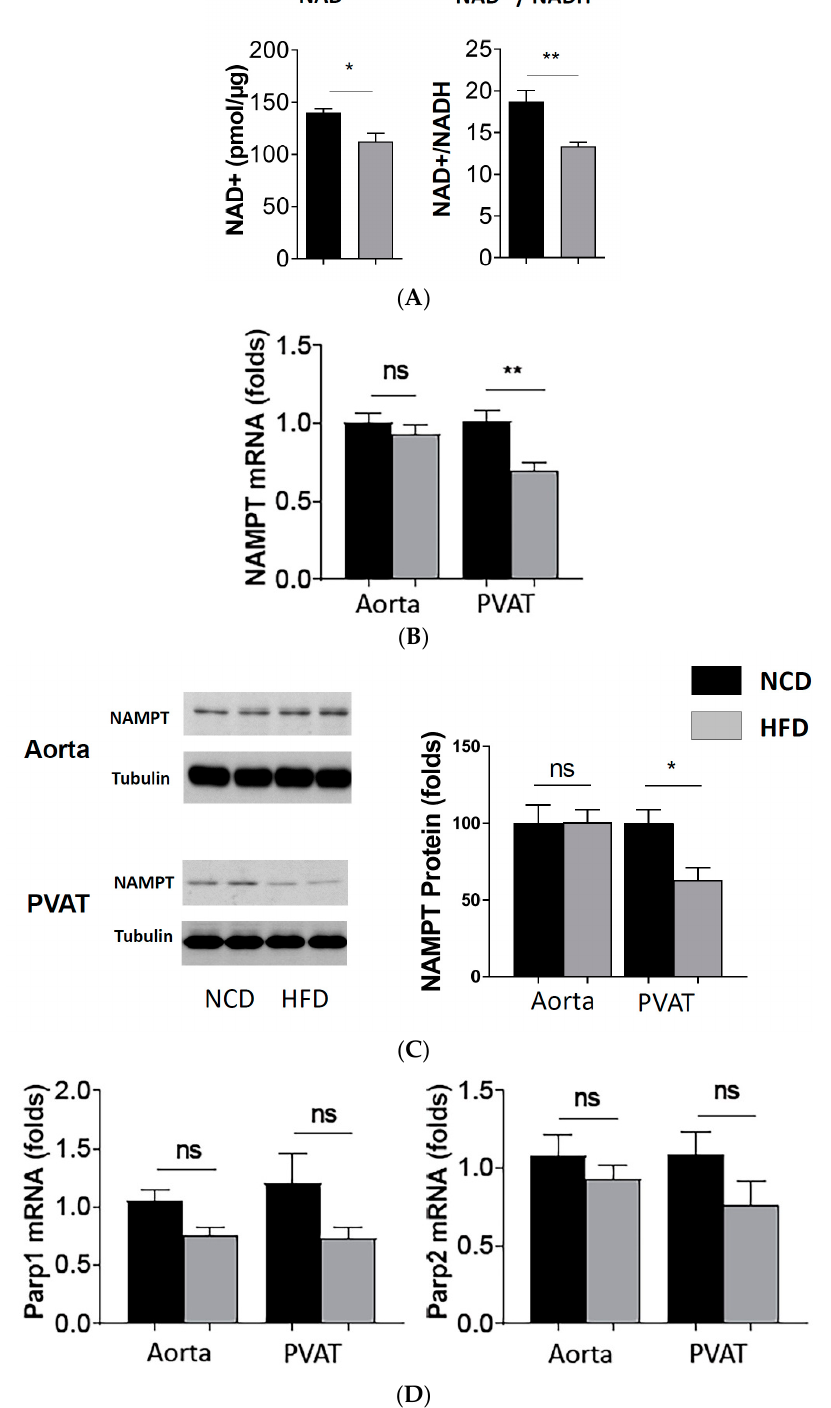
Figure 3. Reduced NAD + level, NAD + /NADH ratio and NMAPT expression in PVAT of diet-induced obese mice. Male C57BL/6J mice were treated with NCD or HFD for 20 weeks. NAD + level and NADH in mouse PVAT lysate were measured with NAD + /NADH Colorimetric Assay kit ( A ). Columns represent mean ± SEM. * p < 0.05, ** p < 0.01, n = 6. The mRNA expression of NAMPT ( B ) was studied with qPCR. Columns represent mean ± SEM. ns, not significant; ** p < 0.01, n = 6. The protein expression of NAMPT ( C ) was studied with Western blot. The blots shown are representative for 3 independent experiments with similar results. ns, not significant; * p < 0.05; n = 10. Parp1 and Parp2 expression ( D ) was studied with (qPCR). n = 10. ns, not